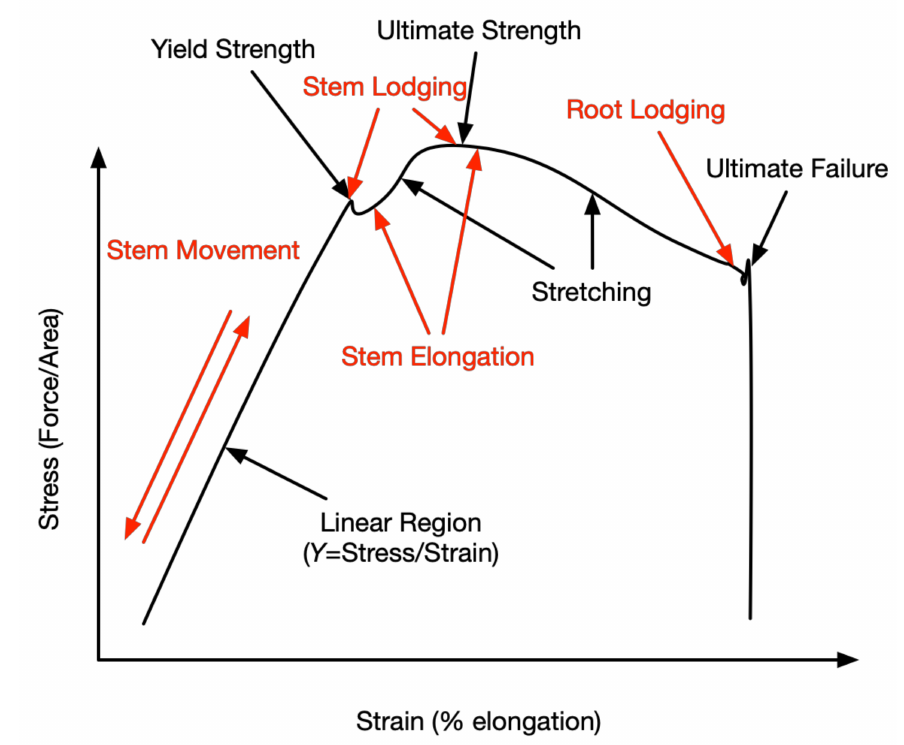
Figure 7. Anatomy of a typical stress-strain curve. The text in red indicates movement for a biomaterial, such as the stem or roots of a